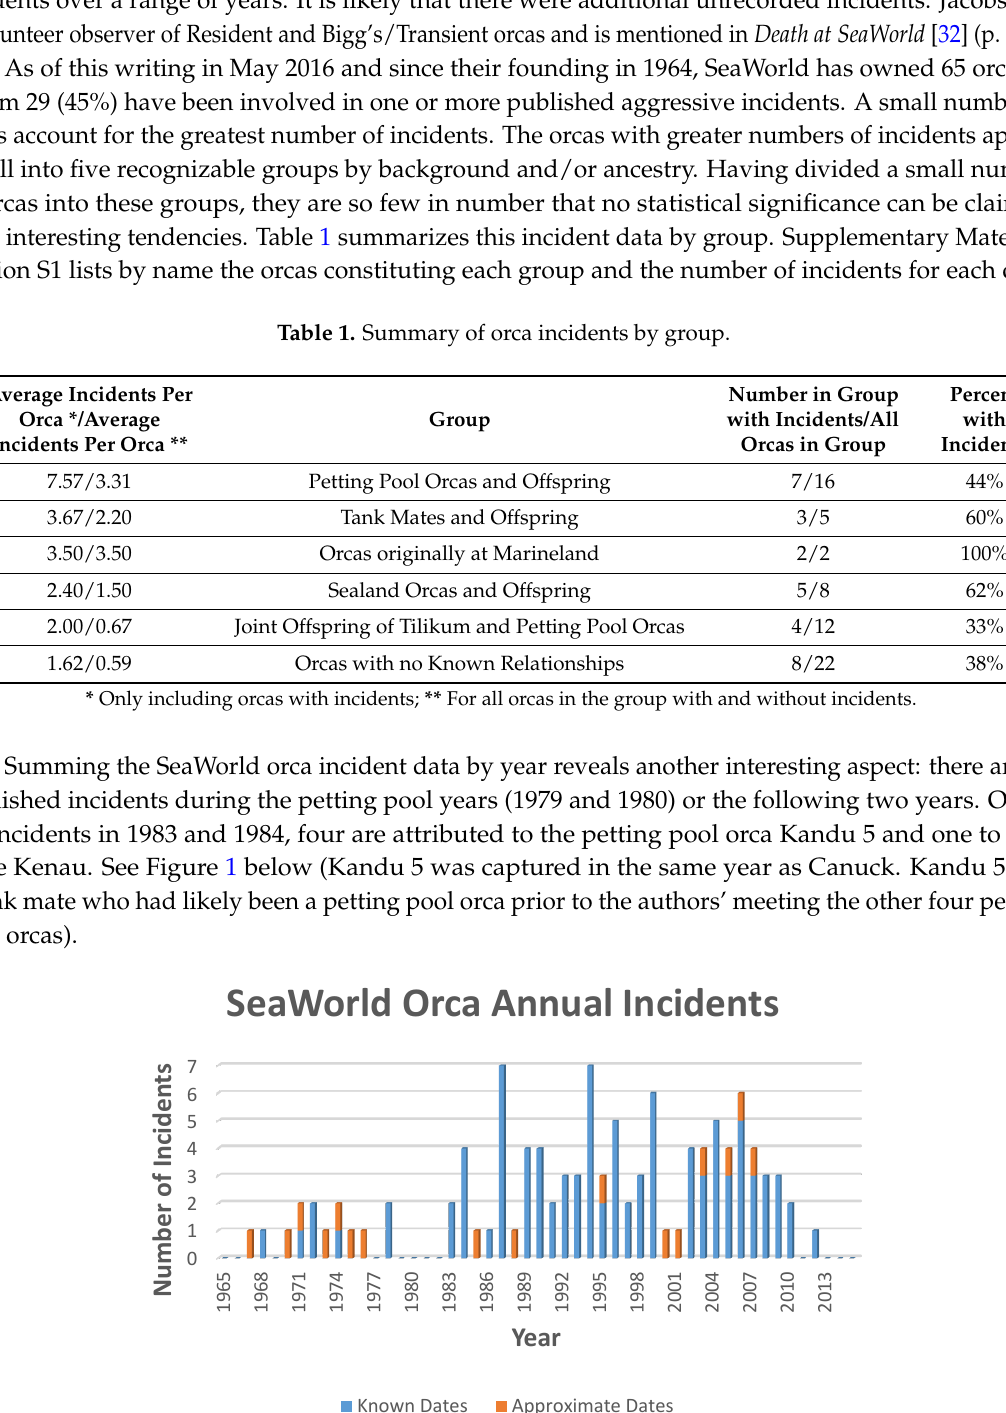
Figure 1. SeaWorld orca annual incidents (Some notes: The orange bars are placeholders representing non-specific entries in the database; Incidents include all those attributed to orcas that were at other oceanaria prior to arrival at SeaWorld, e.g., Tilikum’s two incidents prior to his acquisition by SeaWorld).